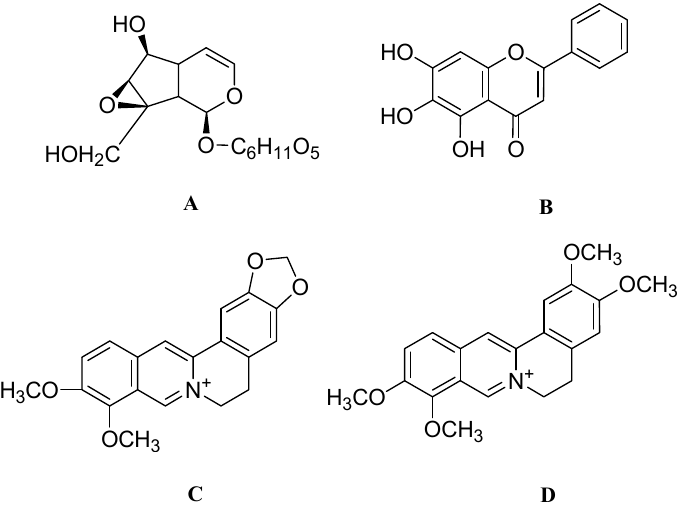
Figure 4. The molecular structures of catalpol ( A ), baicalein ( B ), berberine ( C ) and palmatine ( D